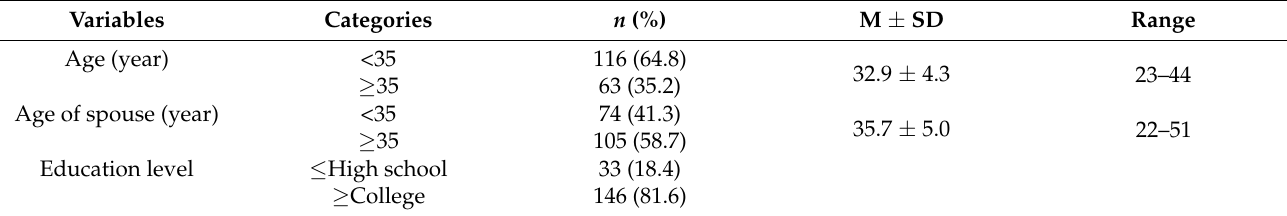
Table 1. General Characteristics of the Participants ( N =